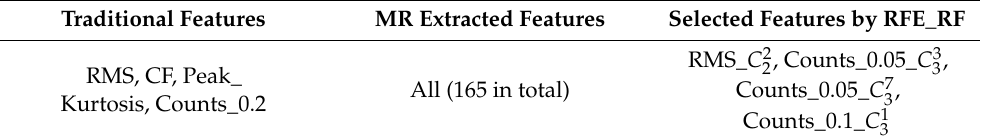
Table 1. Features selected for each feature cluster.